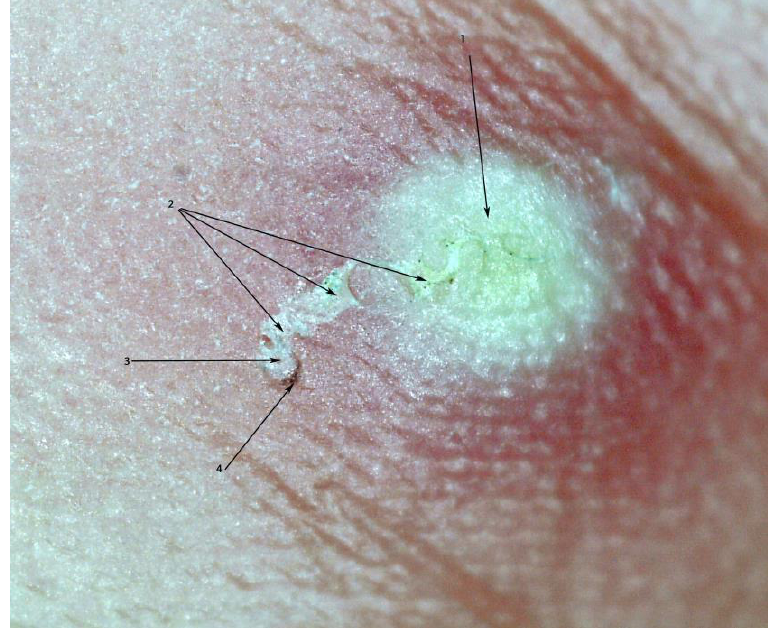
Figure 3. Pearly vesicle (1) and acarine eminence linked by a tunnel (2). The mite is situated at the end of the tunnel with its dorsal part turned towards the surface of the skin (3). The delta-wing sign is clearly visible (4). Photo by digital microscopy; magnification 30-fold.